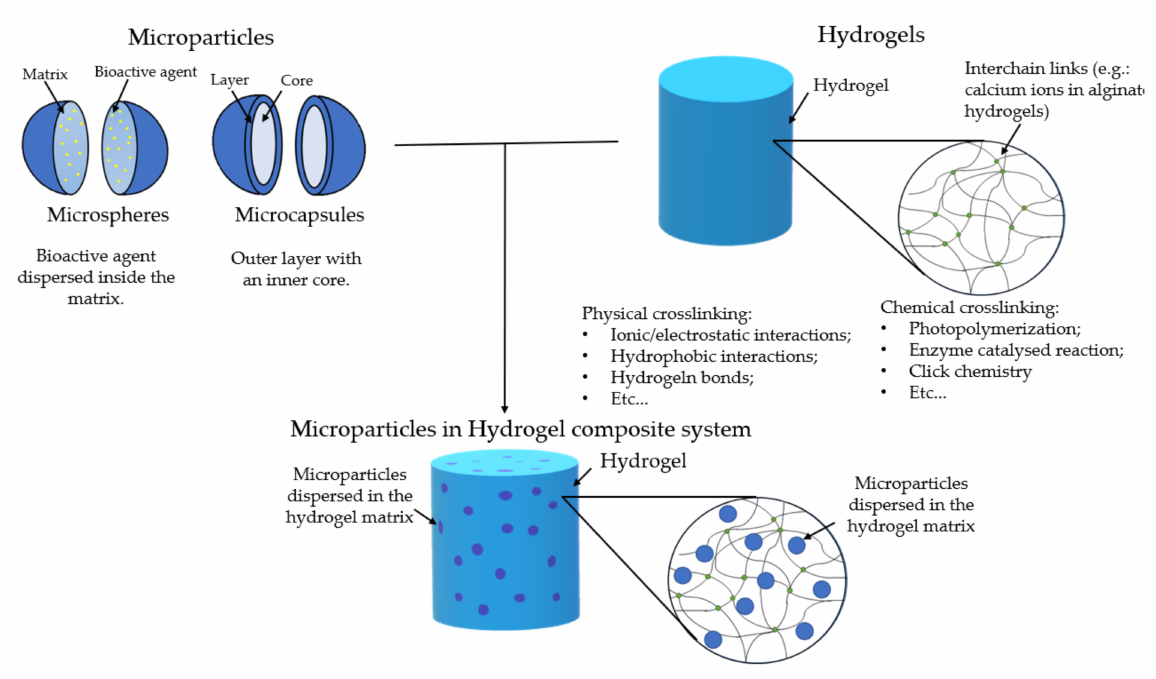
Figure 1. Schematic representation of microparticles (upper left), hydrogels (upper right), and the microparticles in hydrogel system (down).